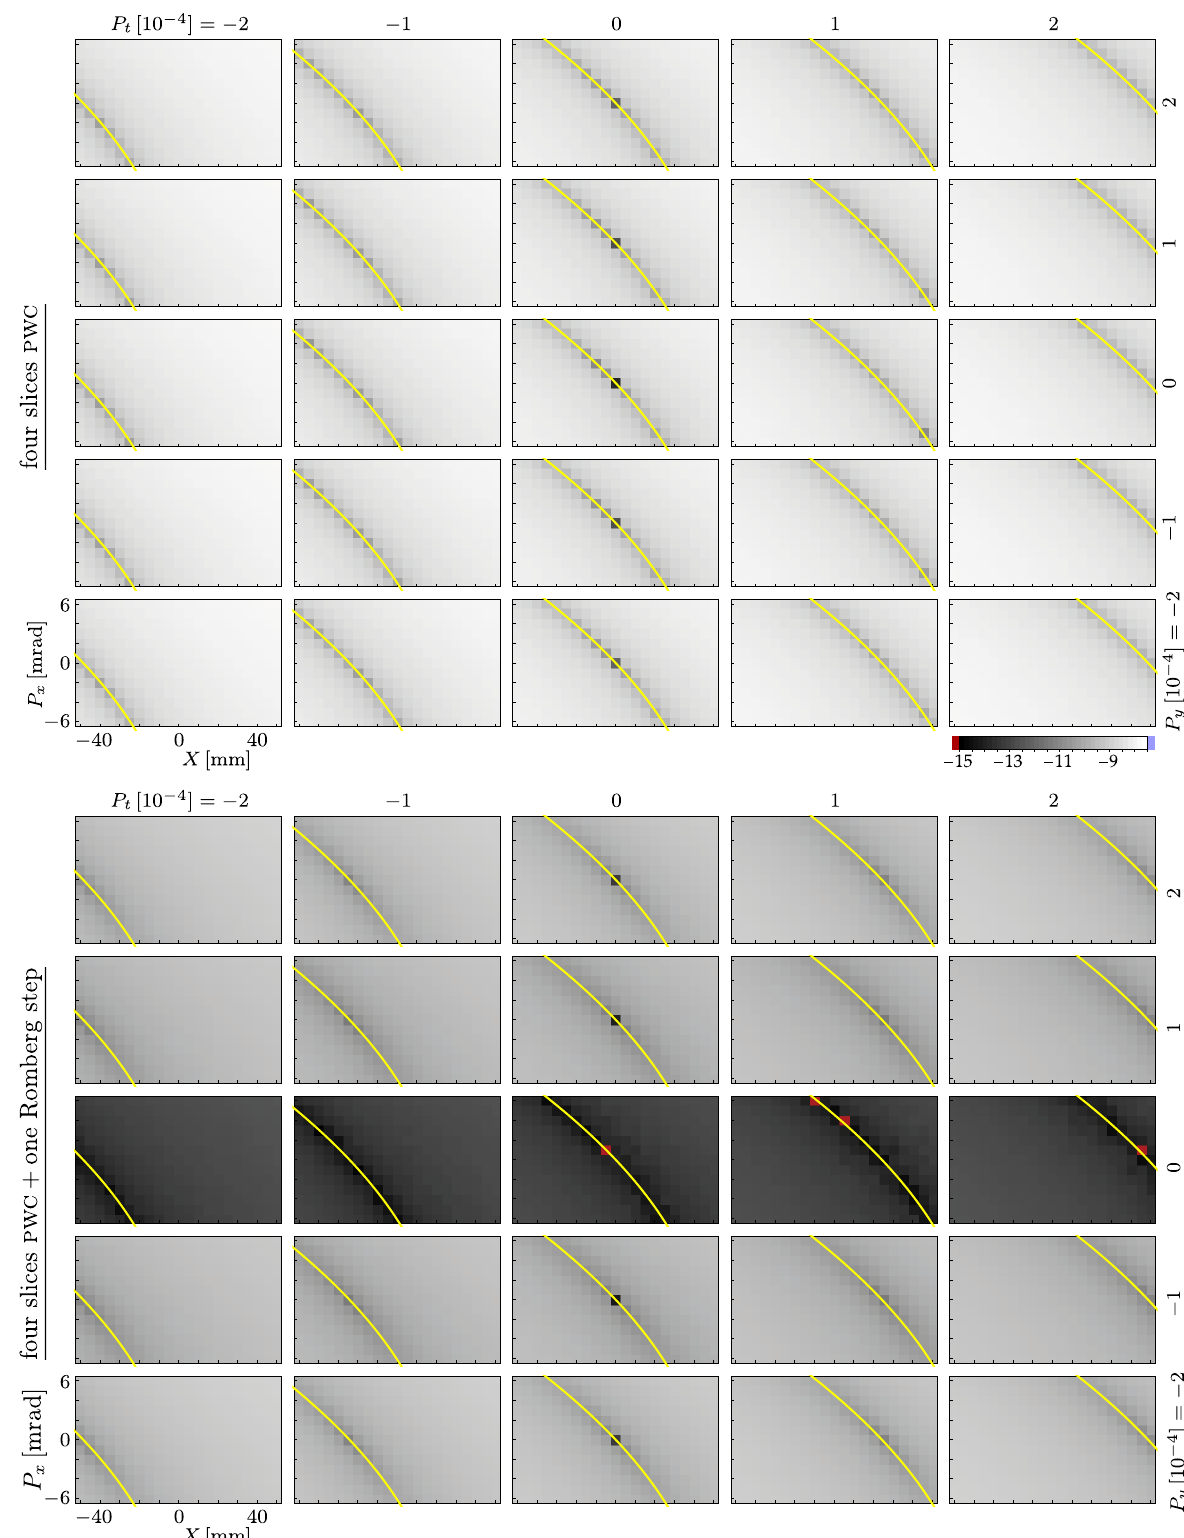
FIG. 10. Absolute error in the computed spin using four slices across a RHIC dipole. Each small graphic covers a range of initial conditions in horizontal phase space (see labels at lower left). The rows and columns correspond respectively to different initial values for P and P (see labels along right and top edges). For the lower set of graphics, we added one Romberg y t